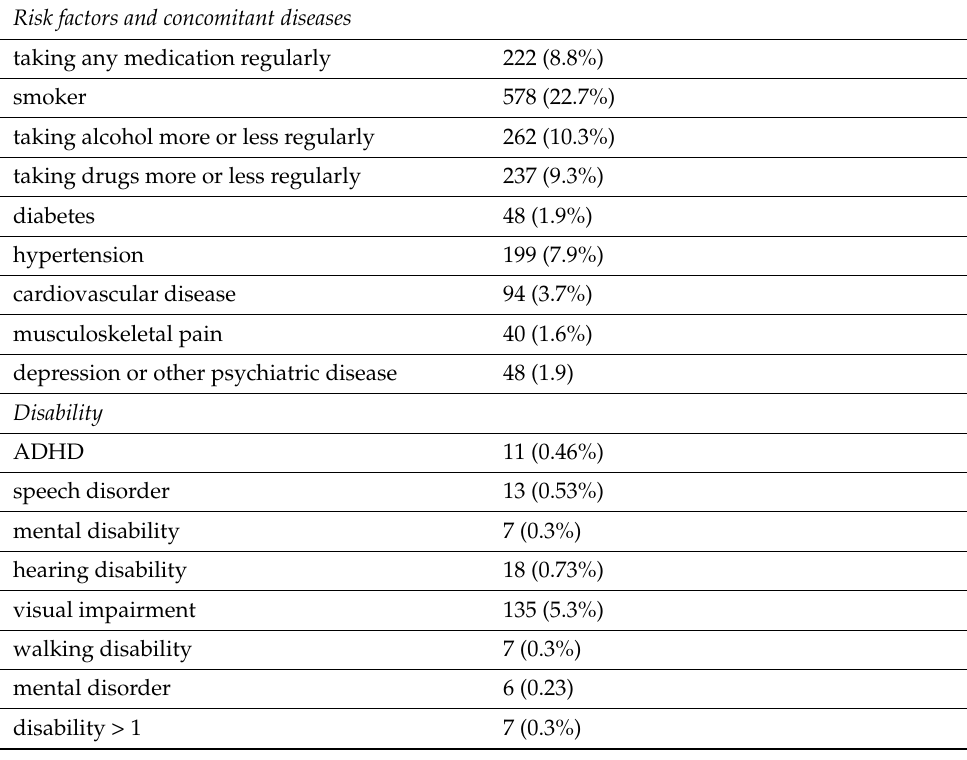
Table 2. Risk factors and concomitant diseases in the study